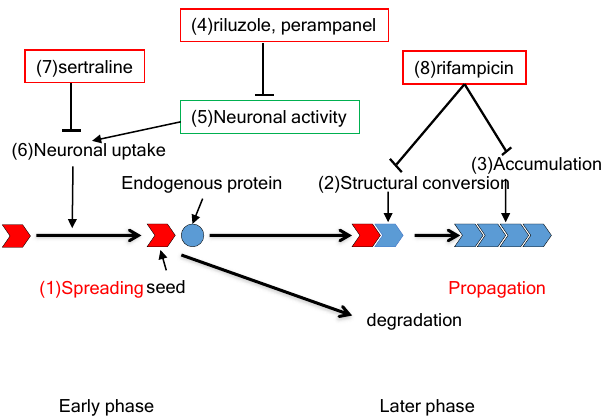
Fig. 6 Schematic view of drug effects on α -syn seed transmission. In the transmission experiment used in this study, seeds are disseminated rapidly (1). Those seeds convert endogenous protein to a misfolded version (2), which could be visible several months later (3). Some drugs such as riluzole and perampanel (4) reduce neuronal activity (5) and attenuate the uptake of seeds (6). Sertraline (7) may reduce seed uptake directly. Rifampicin (8) does not affect this early phase, but reduces structural conversion (2) or accumulation (3) at a later